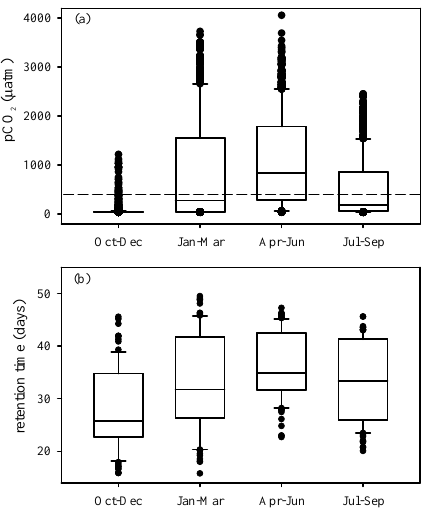
Figure 4. Box plot of the p CO 2 at station S28 near the dam (a) and the mean reservoir retention time (b) over the studied year. The dashed line represents the average p CO 2 in the atmosphere (375µatm). The data are subdivided into four seasons: rainy